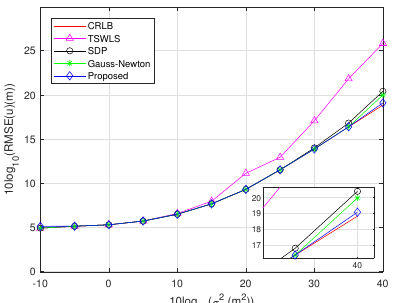
Figure 7. RMSE comparison for estimating target position at σ 2 s = 1 m 2 using three transmitters. Scenario 5: Fixing three transmitters, the number of receiver M increases from 3 to 8.